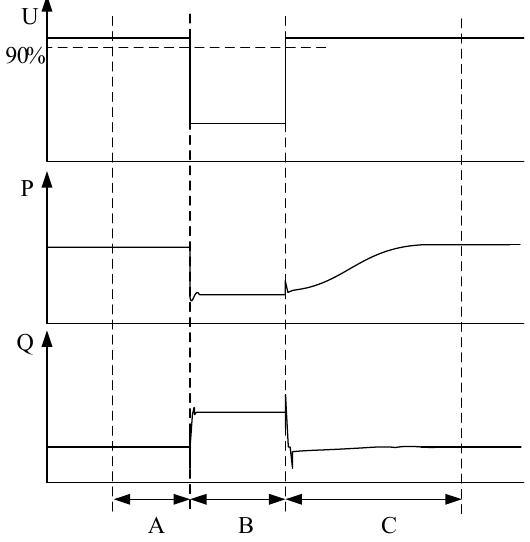
Figure 9. Diagram of division of disturbance intervals.